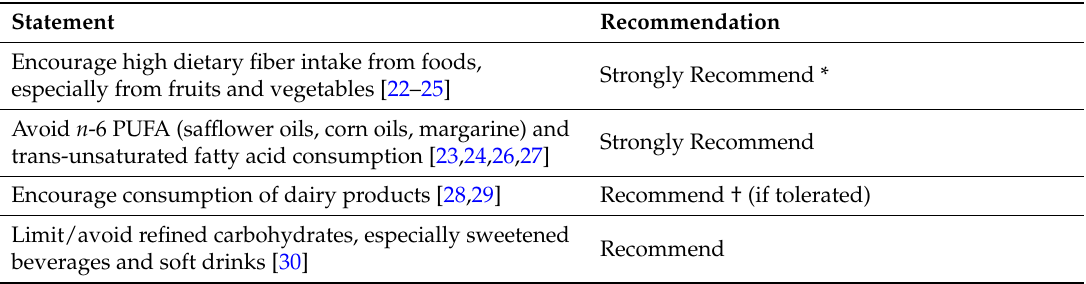
Table 1. Evidence-based diet recommendations for the maintenance of remission in